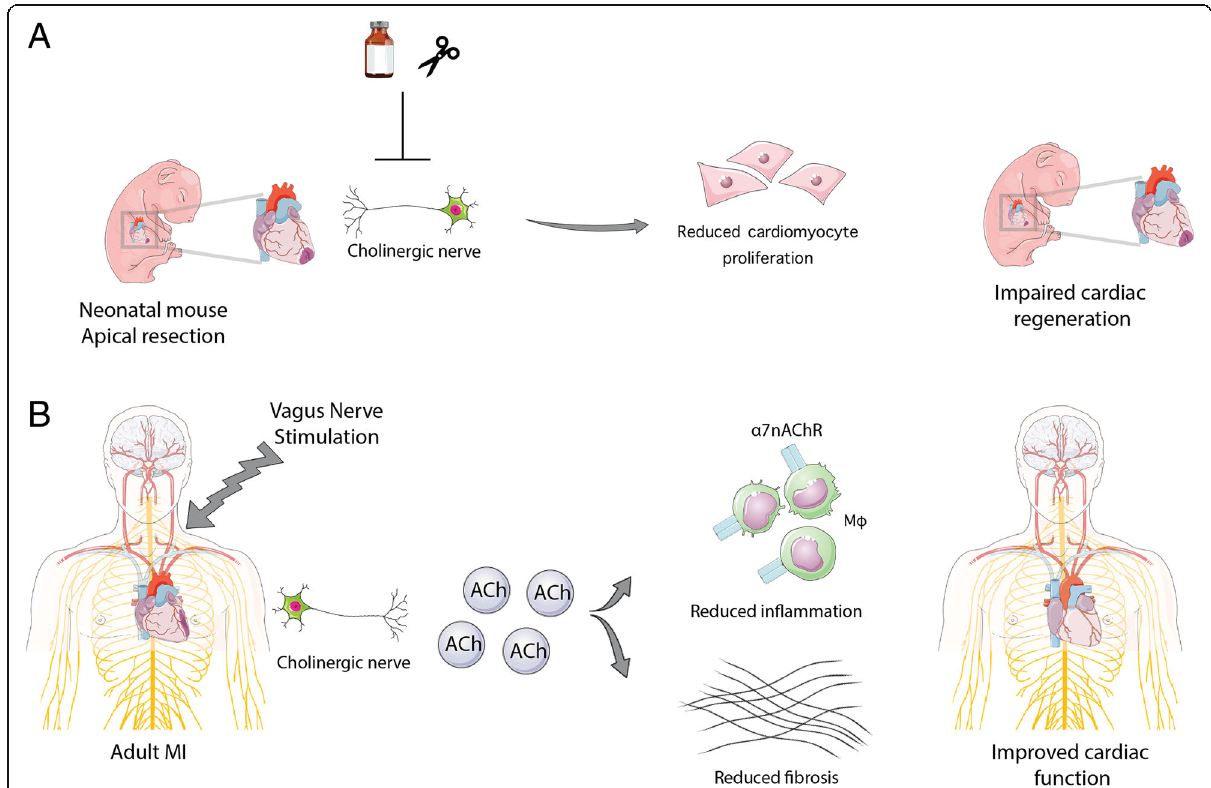
Fig. 1 Cholinergic nerve signaling promotes neonatal heart regeneration and adult heart remodeling following cardiac injury. a The neonatal mouse heart is capable of regenerating following injury, and this regenerative response was demonstrated to be dependent on cholinergic nerve signaling for proper heart regeneration. Pharmacological and mechanical blocking of cholinergic nerves resulted in reduced cardiomyocyte proliferation and failure to regenerate. b Adults with chronic heart failure treated with vagus nerve stimulation showed some improvements in heart function although these clinical studies were preliminary. The mechanisms behind the beneficial role of vagus nerve stimulation in cardiac repair are still not fully understood. However, it is suggested that the beneficial effect of VNS is partly mediated via increased ACh signaling in macrophages through binding to the α 7nAChR. This ultimately results in decreased secretion of pro-inflammatory cytokines and subsequent decrease in the heart ’ s fibrotic remodeling